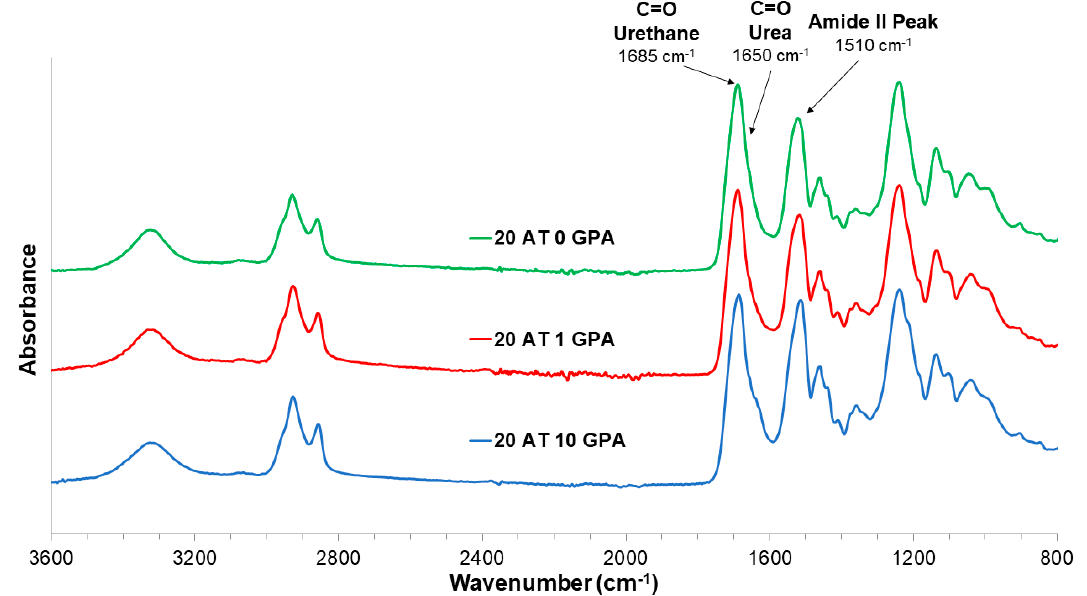
Figure 3. ATR-FTIR spectroscopy results for a selection of compositions with peaks of interest identified (C=O Urethane 1685 cm − 1 , C=O Urea 1650 cm − 1 , Amide II 1510 cm − 1 ).